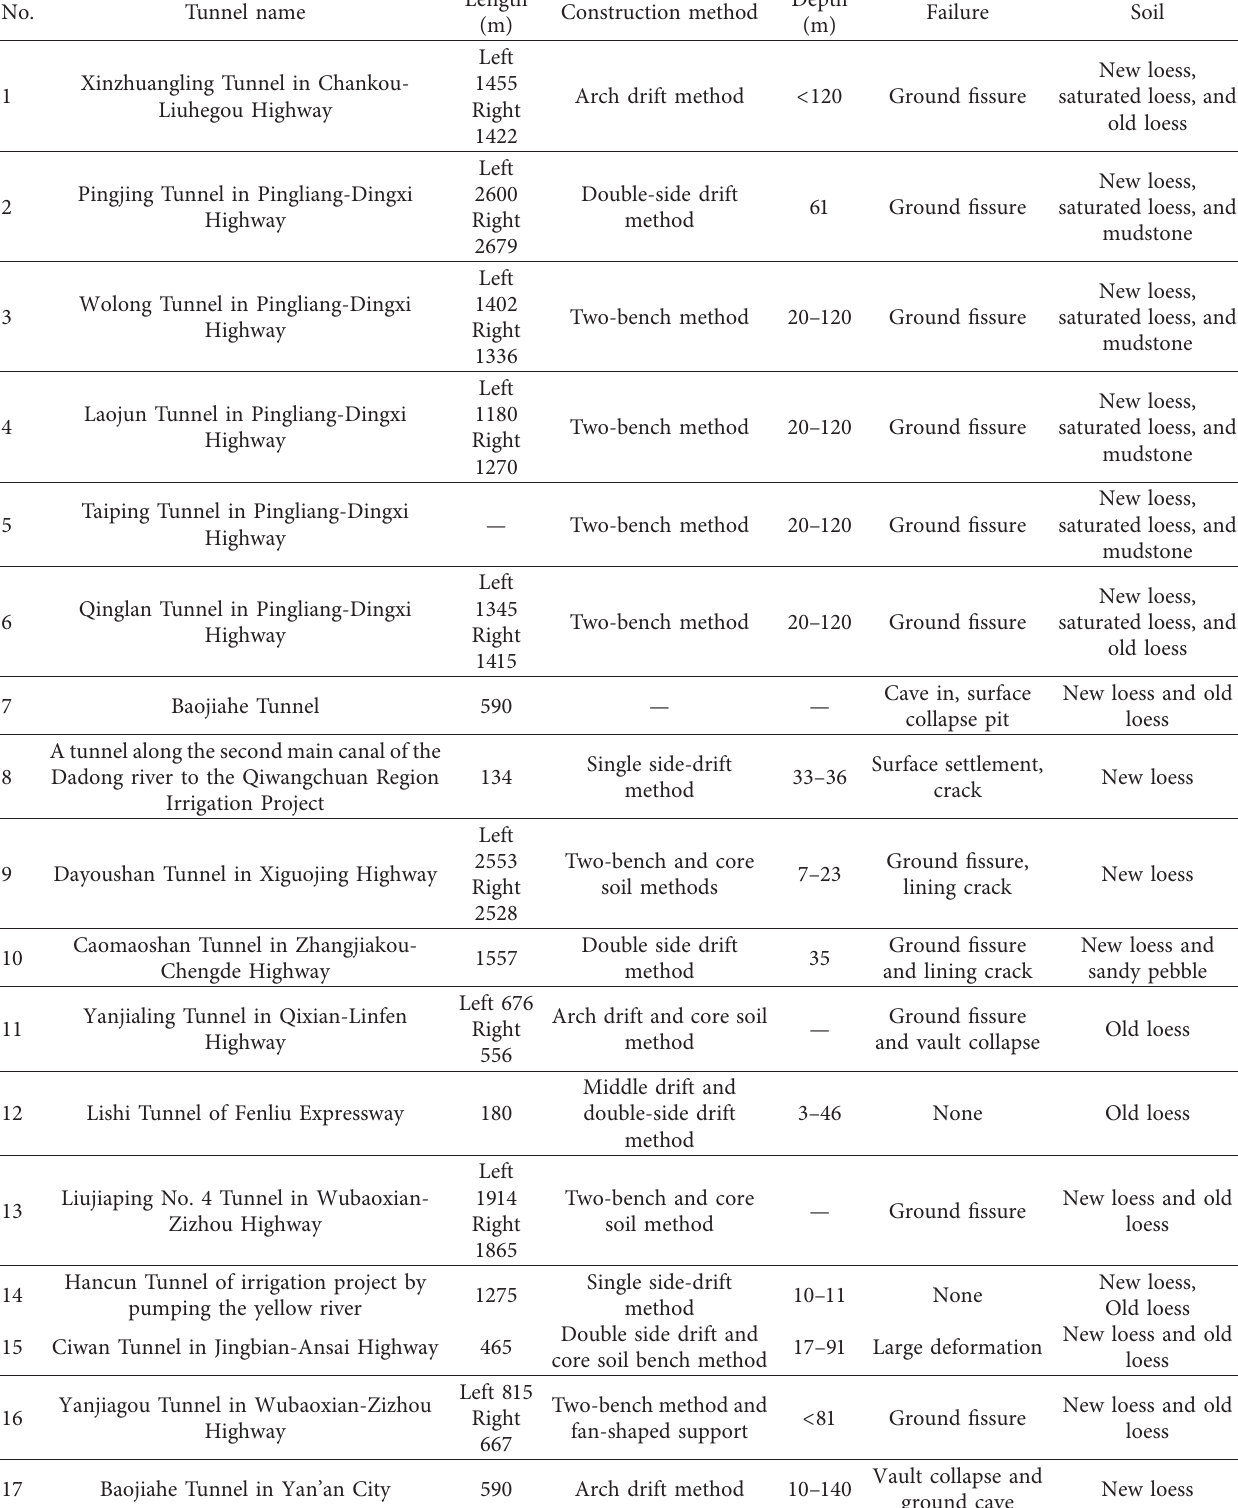
Table 1: Investigation of failures in loess